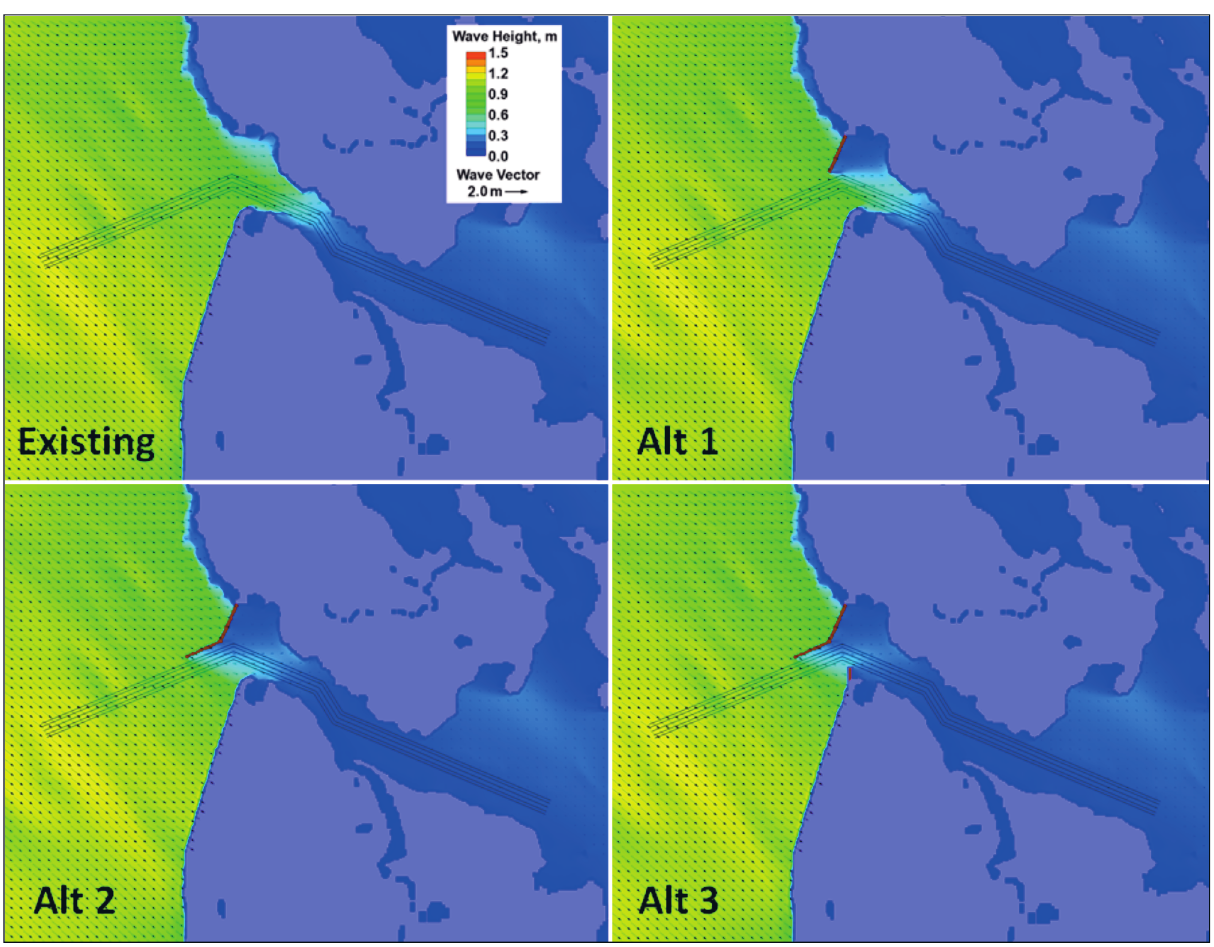
Figure 13. Example of model calculated wave heights in the west channel for the 50-year design winds from NW at 0 m water